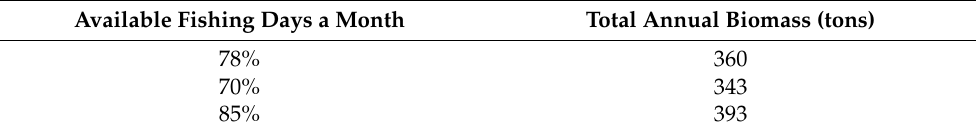
Table 1. Annual biomass (in tons) extracted by recreational anglers from the coast, along the Israeli